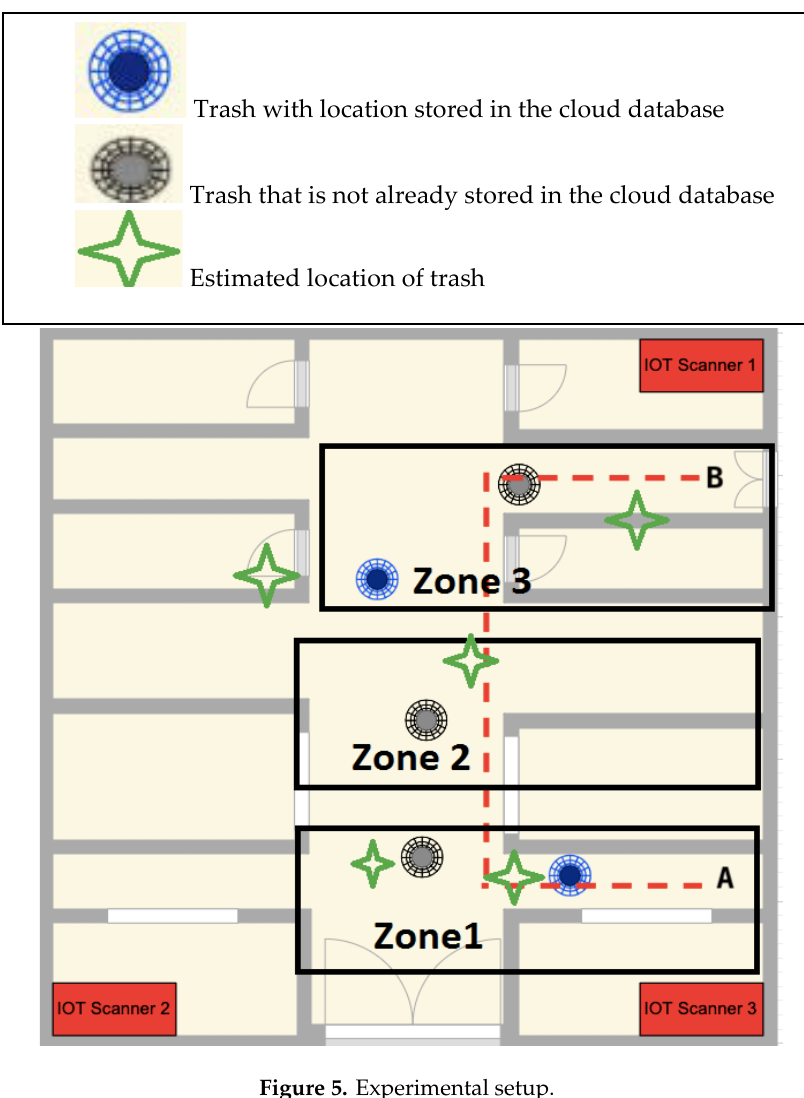
Figure 5. Experimental setup.